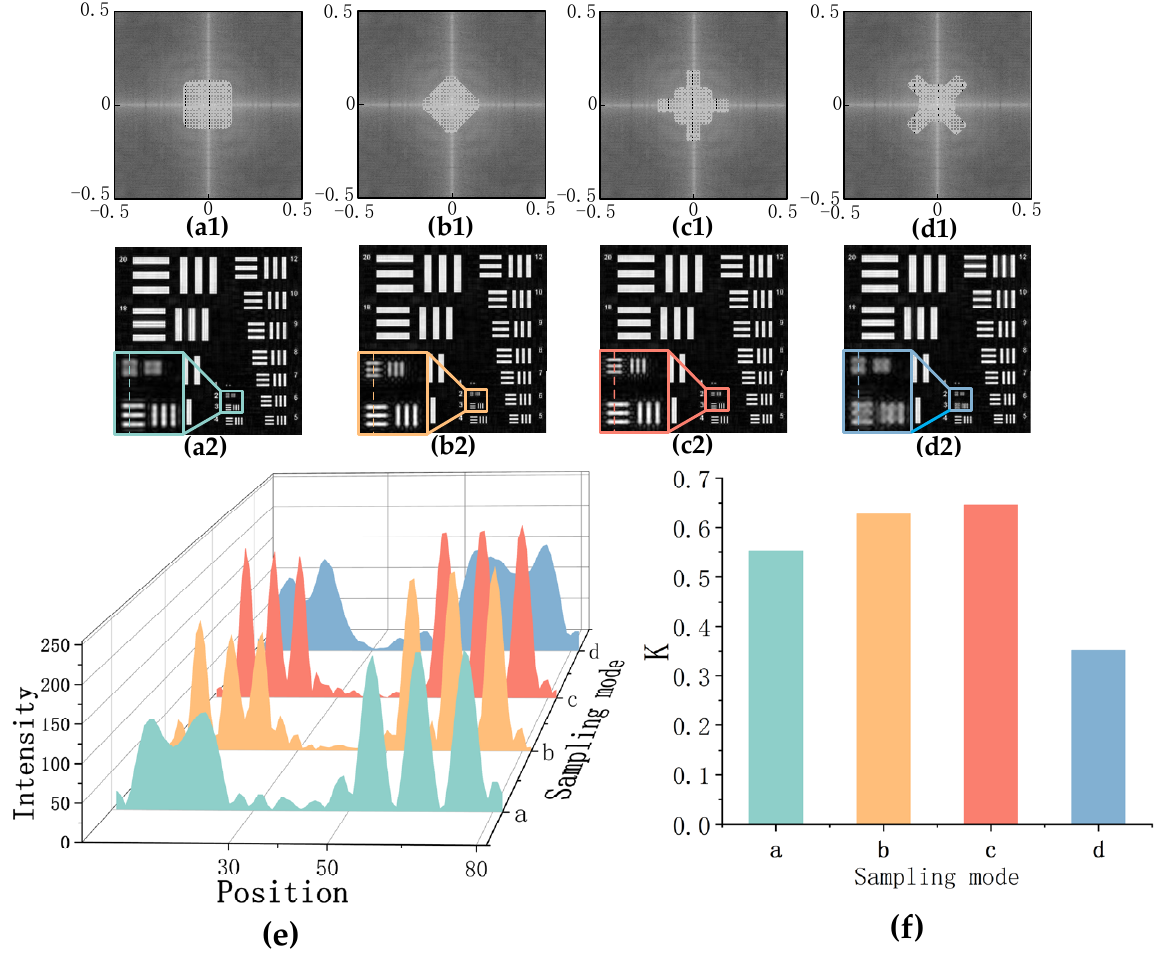
Figure 2. Different sampling modes, reconstruction images and analysis. ( a1 – d1 ) For different spectral sampling modes, the overlap ratio of adjacent apertures in the horizontal and vertical directions is 60%. ( a2 – d2 ) Reconstructed images and partial enlarged images corresponding to different sampling modes. ( e ) Pixel intensity distribution map of the horizontal stripes at group numbers 2 and 3 intercepted at the drawn line. ( f ) The structural similarity values K corresponding to different reconstructed